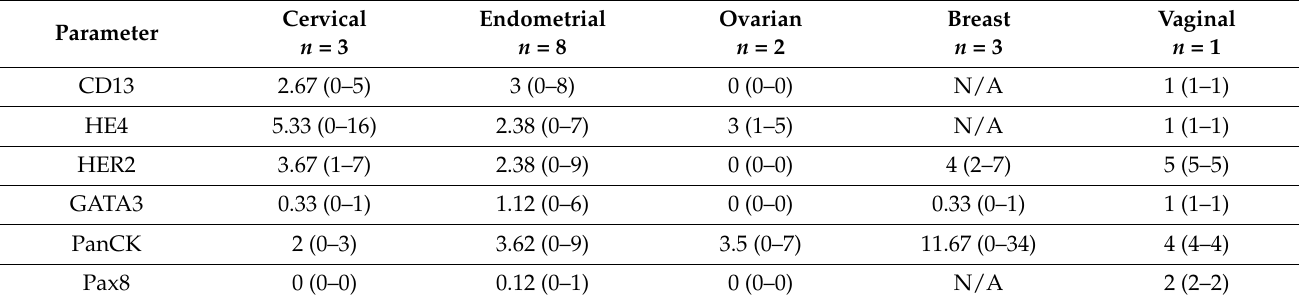
Table 5. Circulating tumor cell counts of the study